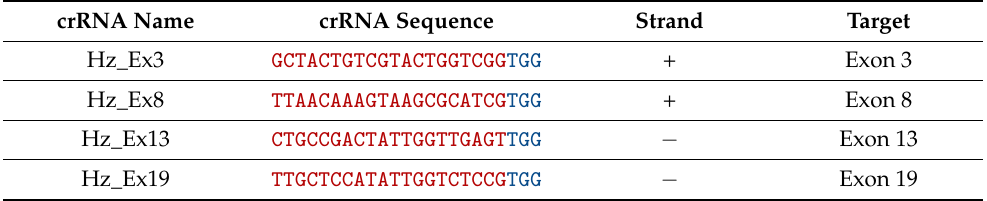
Table 1. CRISPR RNA (crRNA) sequence (red) and protospacer adjacent motif (blue) used for gene (GenBank KY701524). Target sites in the coding DNA strand are denoted by a plus (+) sign, and those on the reverse strand are denoted by a minus ( − )